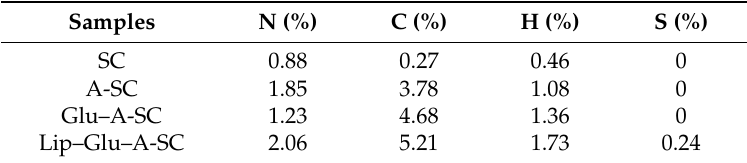
Table 1. The nitrogen, hydrogen, carbon, and sulfur contents of the samples.